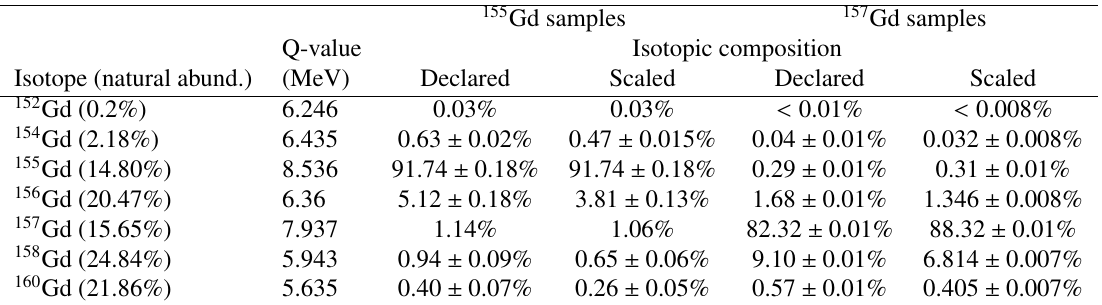
Table 2. Isotopic composition of the gadolinium isotopes and corresponding scaled quantity used in the resonance shape analysis (the Q-value of the (n, γ ) reaction adopted for the calculation of the abundance used in SAMMY is reported). 155 Gd samples 157 Gd samples